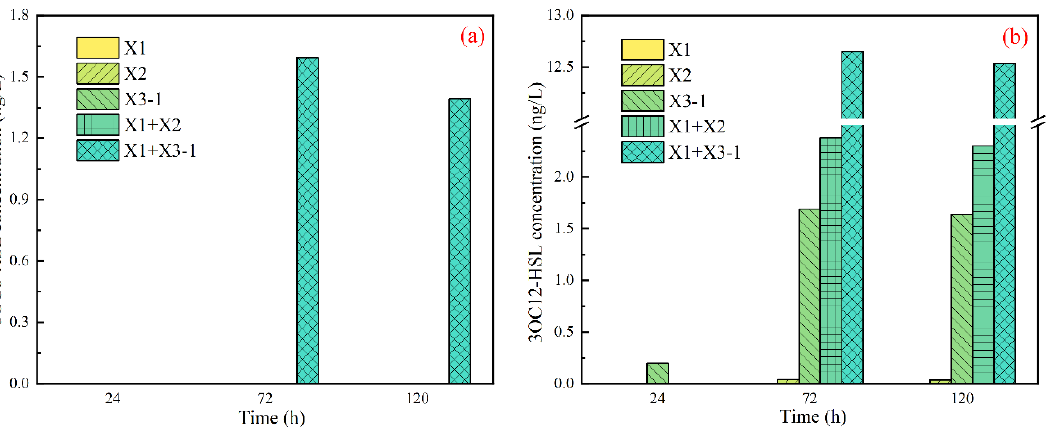
Figure 3. Profiles of 3OC6-HSL( a ) and 3OC12-HSL( b ) with X1, X2, X3-1, X1 + X2 and X1 + X3-1.